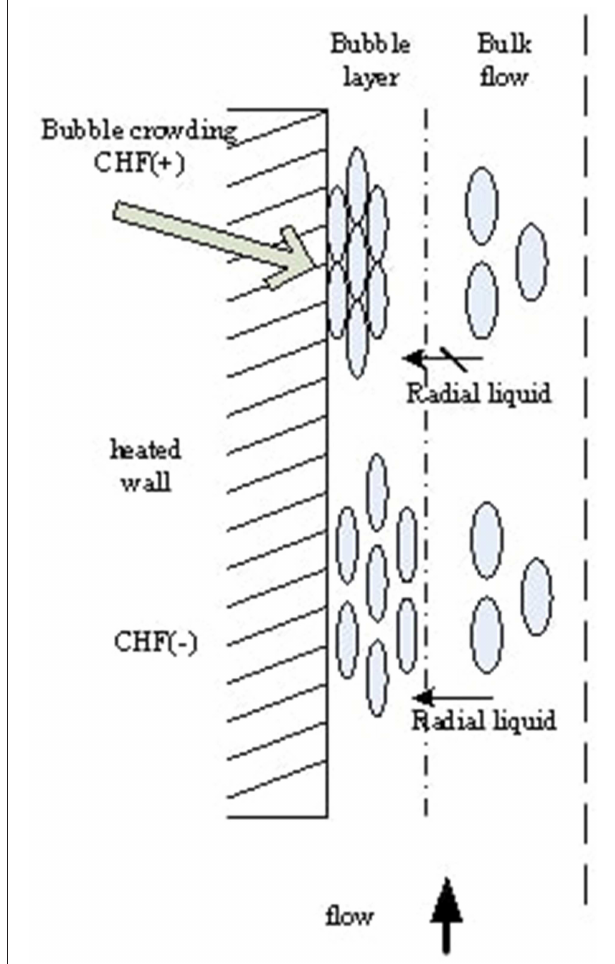
FIGURE 1 | Bubble crowding in vertical